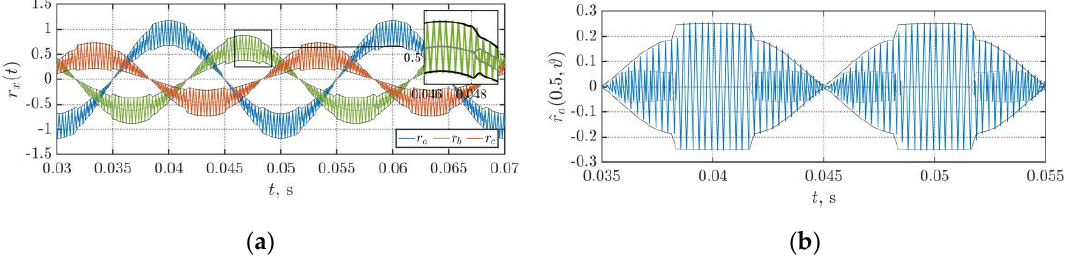
Figure 13. Primary (black) and secondary (gray) envelopes in case of DPWM1 at m = 0.5 and f sw = 3.6 kHz: ( a ) Normalized phase currents; ( b ) Normalized phase current ripple.